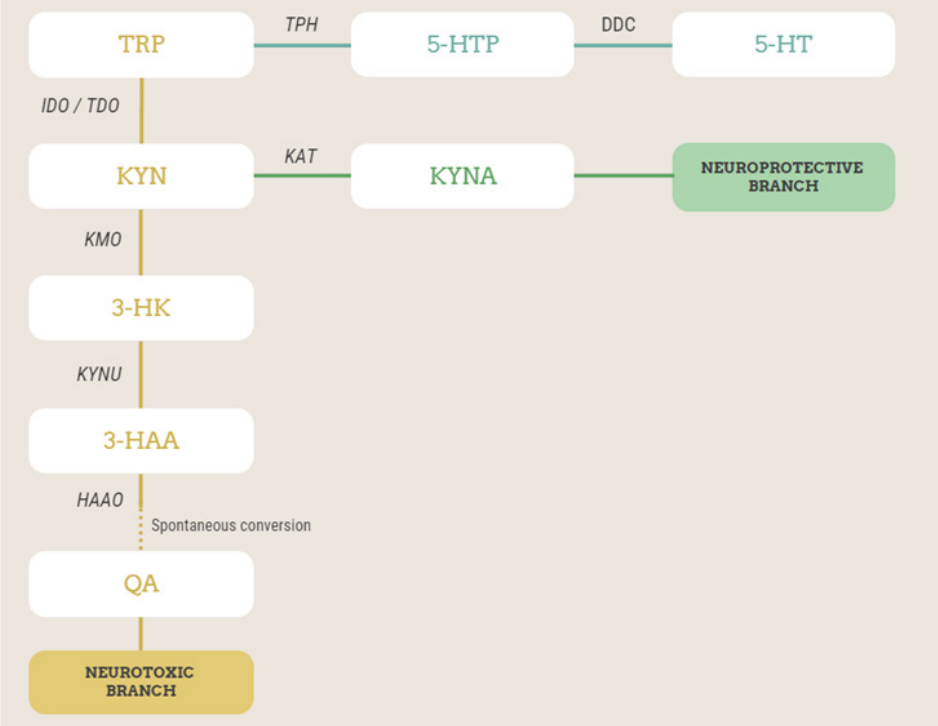
Figure 1. Simplified scheme of TRP metabolism via kynurenine and serotonin pathways, with the metabolites and enzymes studied in this work highlighted. Metabolites in the orange branch are neurotoxic, while those in the green branch are neuroprotective. TRP, tryptophan; 5-HTP, 5- hydroxytryptophan; TPH, tryptophan hydroxylase; DDC, L-amino-acid decarboxylase; 5-HT, serotonin or 5-hydroxytryptamine; KYN, kynurenine; IDO, indoleamine 2,3-dioxygenase; TDO, tryptophan 2,3-dioxygenase; KATs, kynurenine aminotransferases; KYNA, kynurenic acid; KMO, kynurenine 3-monooxygenase; 3-HK, 3-hydroxykynurenine; KYNU, kynureninase; 3-HAA, 3-